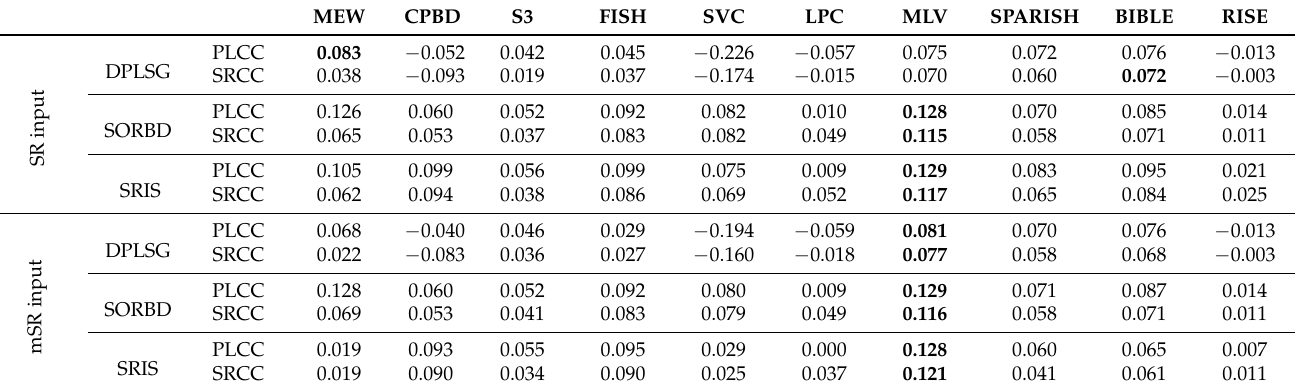
Figure 8. Absolute score difference in each image in TID13 using the SORBD method and the MEW model. The corresponding images are given next to the points of the three largest score drops. The three images show various levels of blurring distortion. (The figure can be enlarged for view). Table 3. Center region (CR) input as the baseline for BISA comparison of the